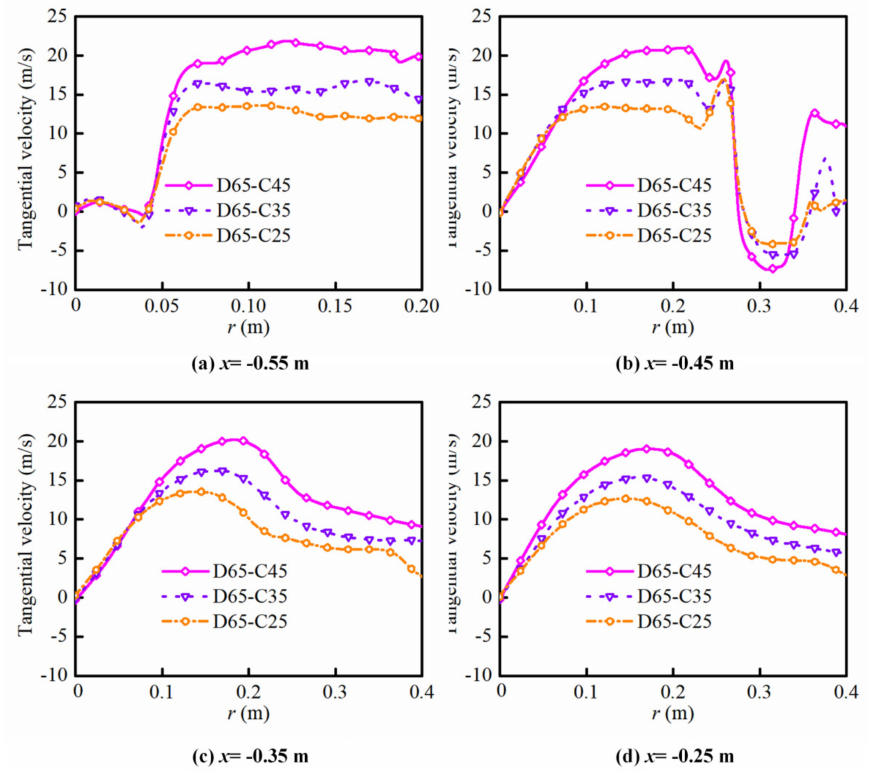
Figure 19. Tangential velocity distribution of D65-C45, D65-C35, and D65-C25 at different axial